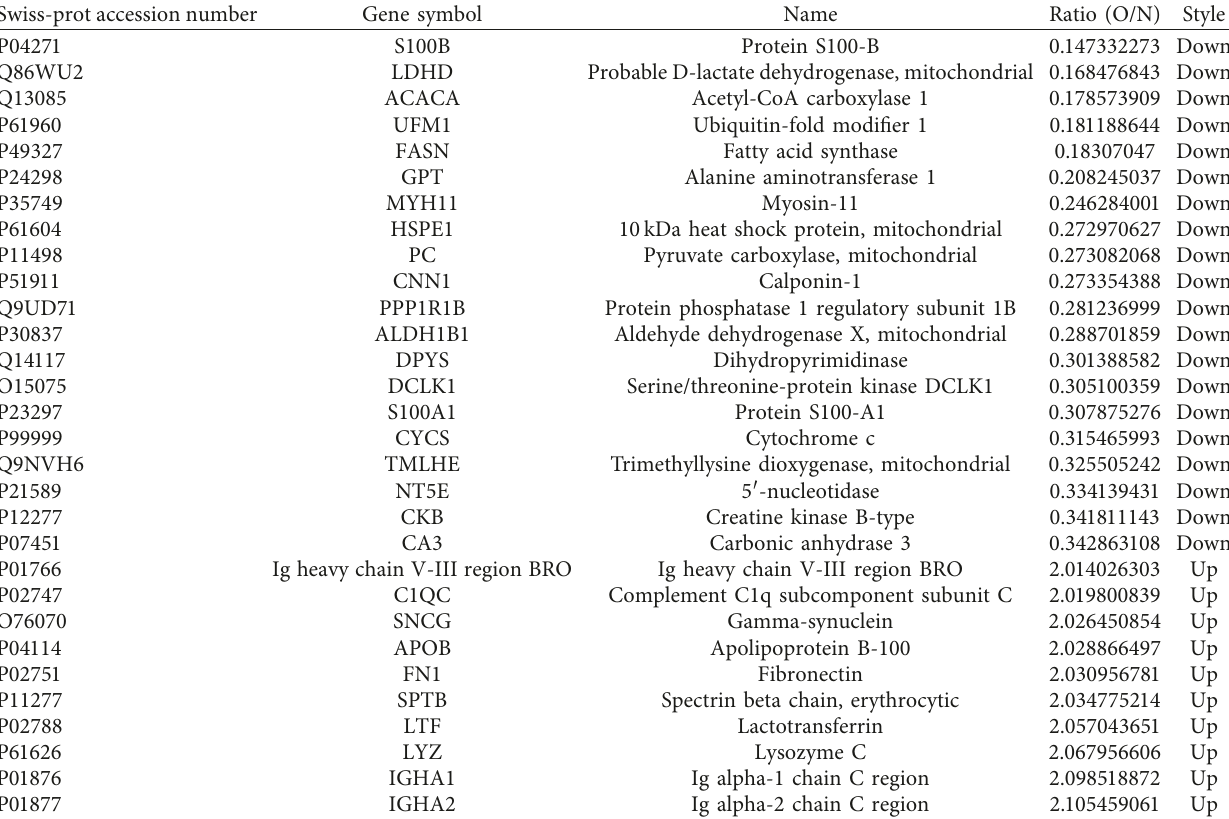
Table 2: List of differentially expressed proteins with top changing